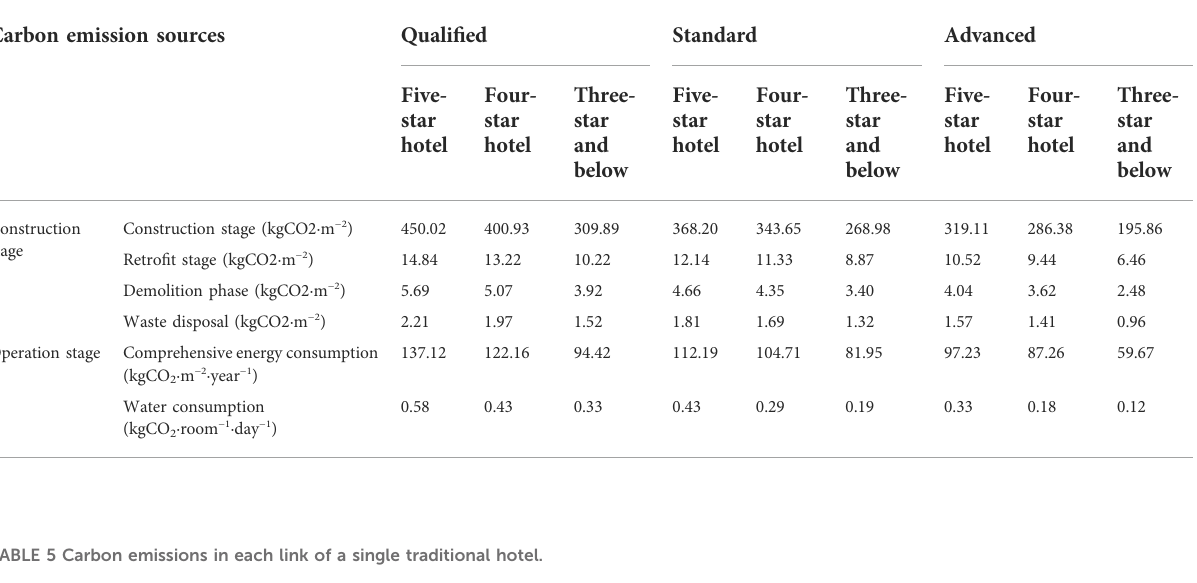
TABLE 4 The carbon emission factors of green hotels.